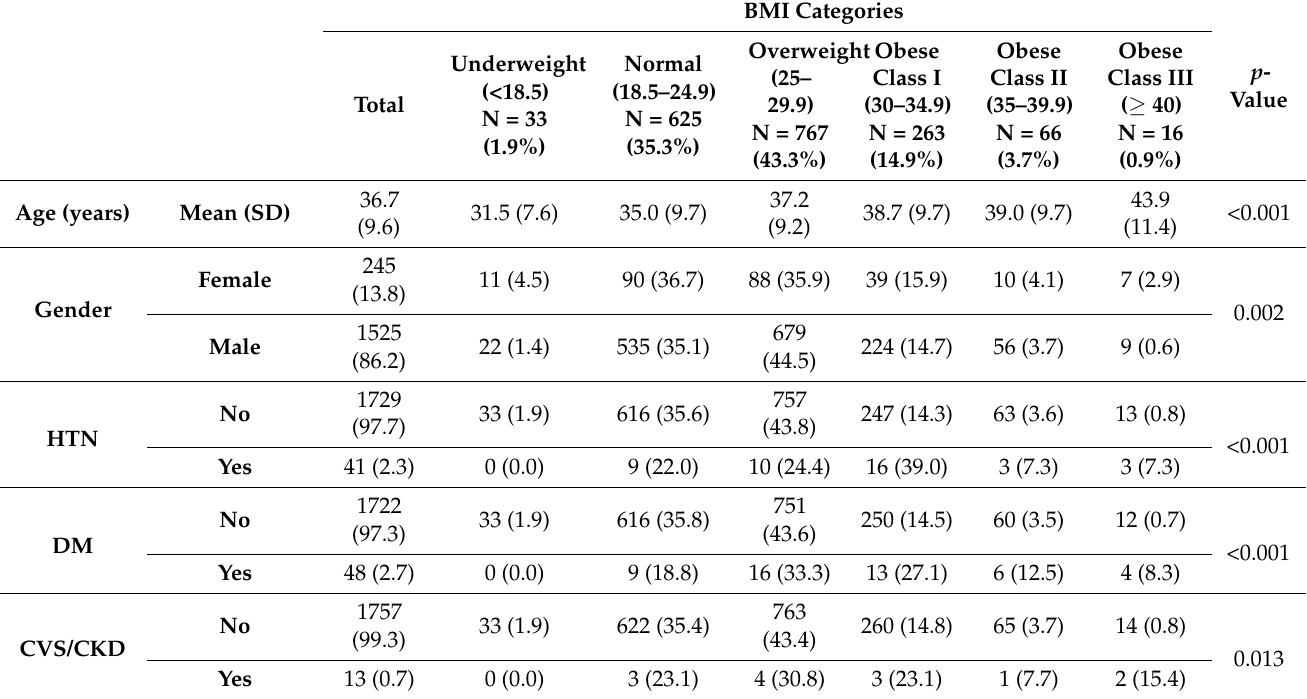
Table 1. Baseline demographic characteristics based on BMI